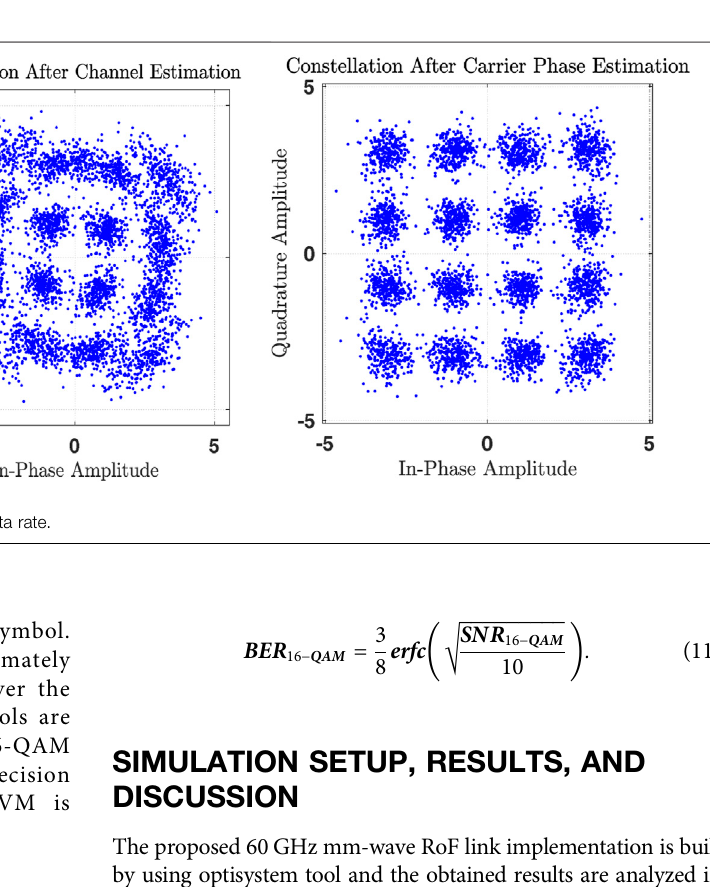
FIGURE 8 | 16-QAM constellation at 115 km SSMF for 110 Gbps data rate.